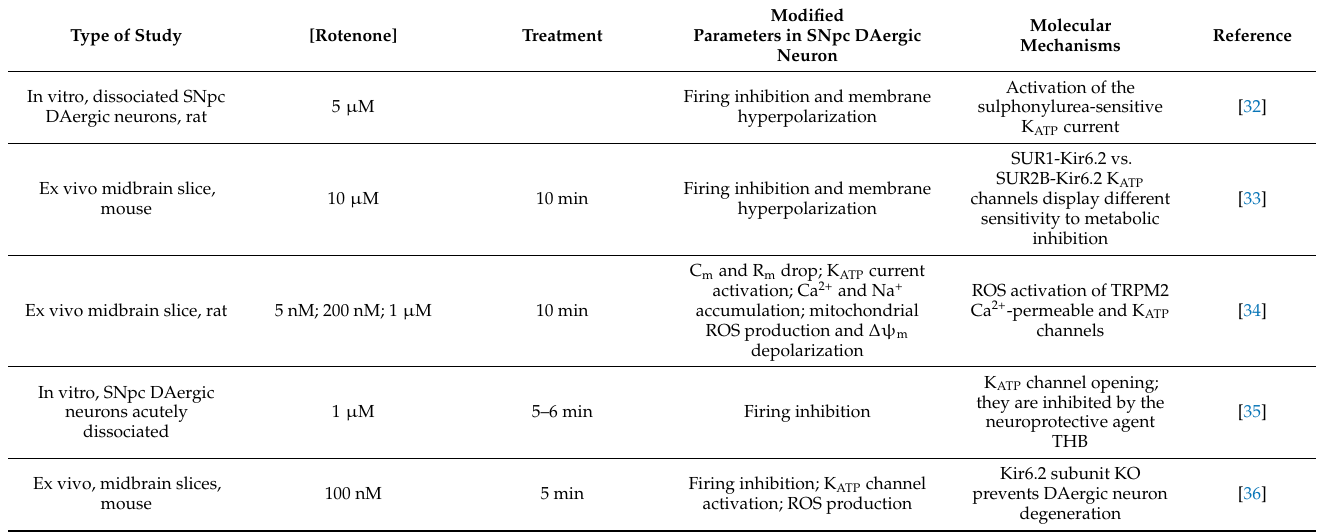
Table 2. Summary of the principal findings of the cited literature on rotenone’s effects on SNpc DAergic neuron functional